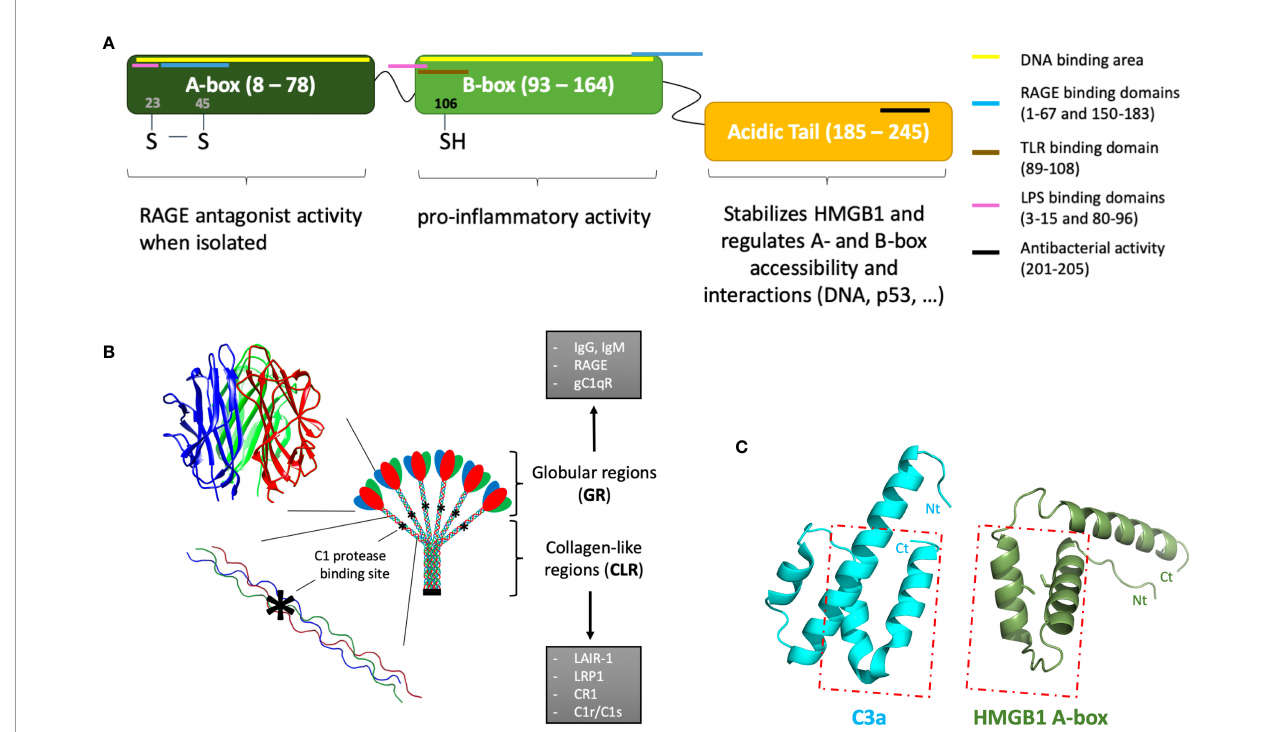
FIGURE 1 | Introductory molecular schemes on HMGB1, C1q, and C3a underlying their multiple functions. (A) HMGB1 function is modulated by its two DNA- binding boxes (A-box and B-box) and an acidic C-terminal tail. By binding to different receptors, targets and partners (see color bars), HMGB1 can play multiple extracellular functions. Interactions restricted to intracellular functions are not shown. The X-ray structure of the A-box is shown in (C) , with its two cysteines shown as sticks. HMGB1 location within cells depends on its nuclear localization signals (NLS), located in the A-box (24 – 44) and B-box (179 – 185). (B) The largest multivalent C1q molecule can bridge different receptors or partner molecules through two regions with strongly different structural shapes and interaction properties. C1q is assembled from three different chains (red, blue, green), with numerous post-translational modi fi cations, especially in the collagen-like regions (CLR). The globular regions (GRs) are mostly involved in the multivalent binding of target surfaces. Its main target ligands are surfaces opsonized by IgG, IgM, CRP, PTX3. C1q GR can also directly bind to DNA, phosphatidylserine, annexins, GAPDH, as well as to lipopolysaccharides (LPS) or virus surface proteins (HIV-1 gp41, HTLV-1 gp21). Some surface receptors bind to C1q GR, such as RAGE, gC1qR, DC-SIGN or Siglec 3 (CD33). C1q CLR mostly binds effector molecules, such as the C1r and C1s proteases, or LAIR-1, CR1, LRP1 surface receptors. These latter interactions are almost exclusive, because the proteases compete with receptor binding. The C1r/C1s protease binding site (*) has been fi nely investigated by C1q site-directed mutagenesis (1). (C) The similarity between HMGB1 A-box and C3a is very limited, despite the fact that both are small helical domains which can bind RAGE. The C3a and C5a anaphylatoxins are the smallest fragments released upon C3 and C5 cleavage. They are composed of helices, which is a feature common to HMGB1 boxes. However, only the two C-terminal helices of the A-box can roughly be superimposed to the two N-terminal helices of C3a (see box), in the opposite direction: therefore, the similarity between the two molecules is very limited [PDB codes 1ckt (2) and 4hw5 (3) for A-box and C3a,